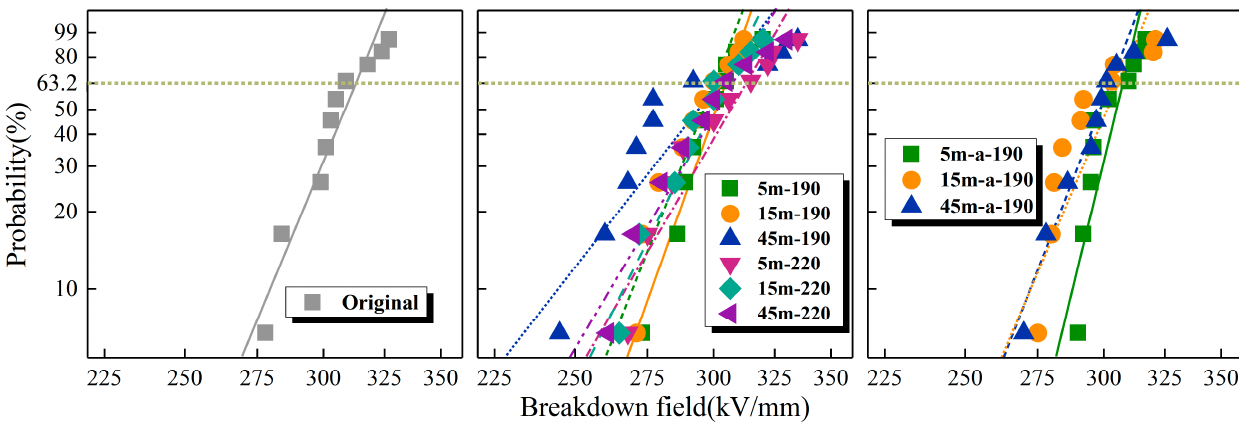
Figure 10. Weibull distribution of DC breakdown strength of samples. Table 2. Scale parameter ( α ) and shape parameter ( β ) of samples.